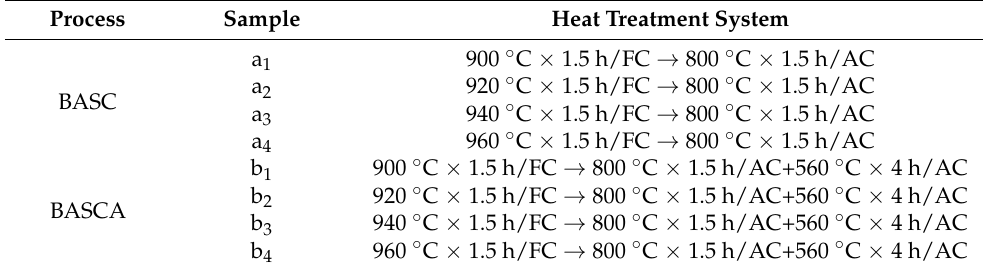
Figure 4. Geometry of the tensile specimen. Figure 3. Sampling position of tensile specimen. Table 1. BASC and BASCA heat treatment system.